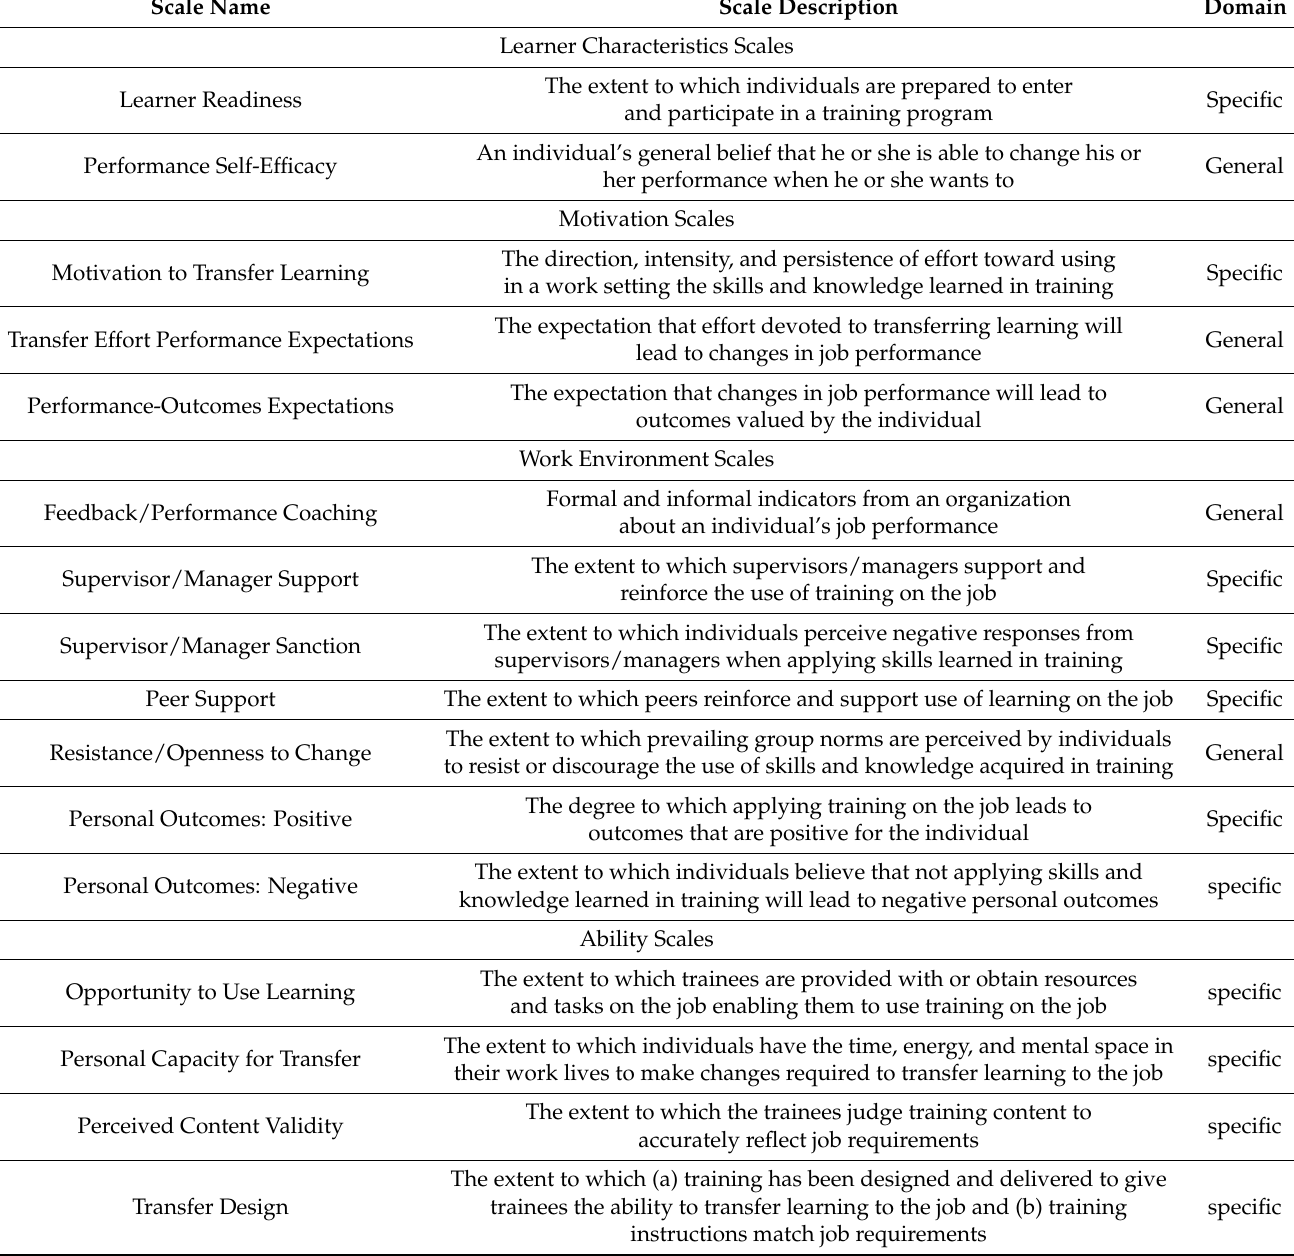
Table 1. Learning Transfer System Inventory (LTSI) Scale